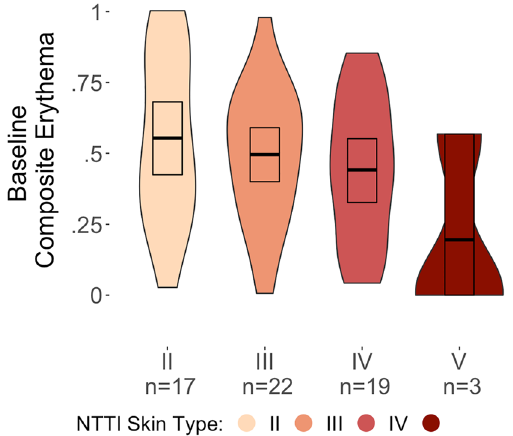
Figure 3. Violin plots summarizing means, 95% CIs, and distributions for Baseline Composite Erythema across NTTI Skin Types. In line with PI-MED’s intended standardization of UV dosage across skin types, differences in Composite Erythema between NTTI Skin Types II, III, and IV appeared to be relatively minimal and were non-significant. However, average Composite Erythema for NTTI Skin Type V was substantially lower than that of the other skin